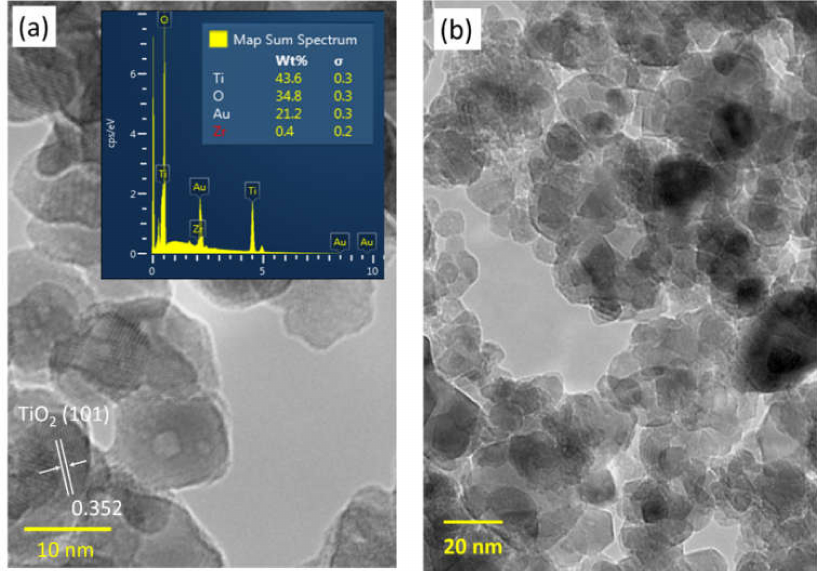
Figure 3. Transmission electron microscopy (TEM) images of ZrO 2 -TiO 2 nanoparticles. ( a ) TiO 2 crystal spacing with inset shows the peaks and the percentage of elemental composition and ( b ) Small agglomeration and dispersion of nanoparticles.